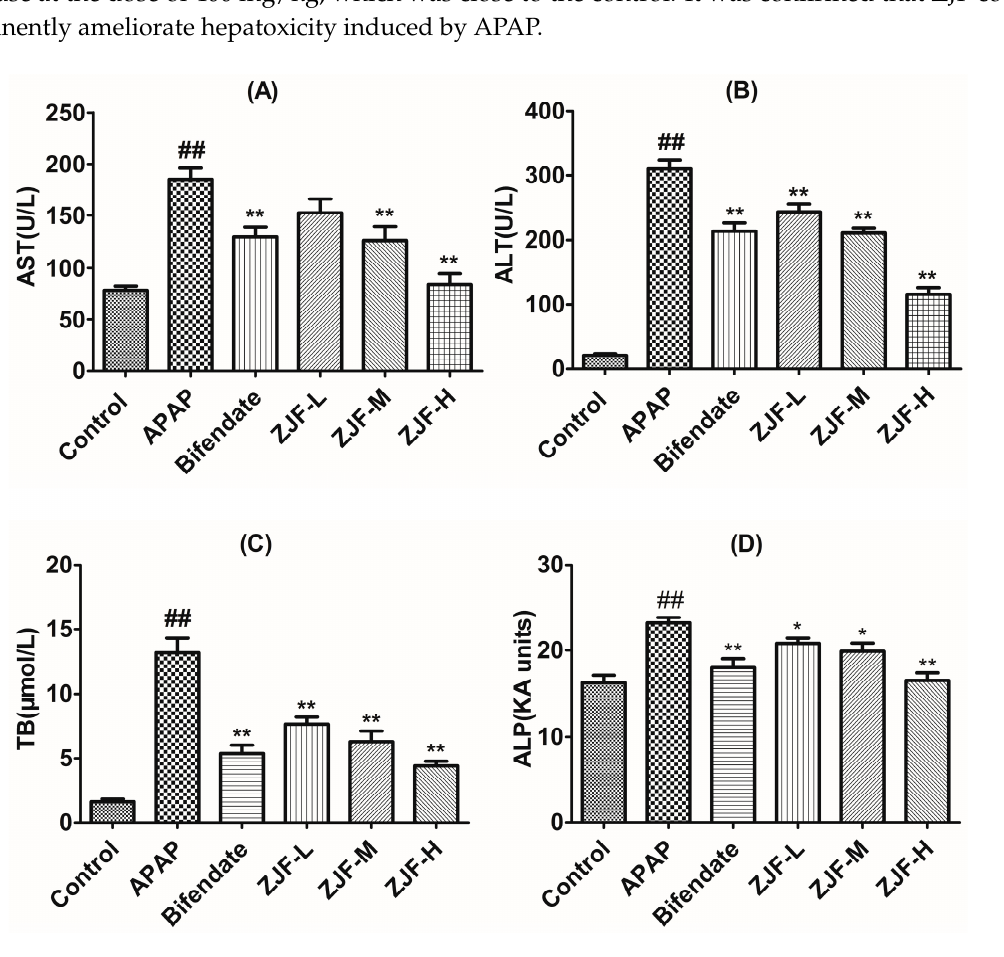
Figure 3. Preventive effects of different doses of ZJF on the activities of serum aspartate aminotransferase (AST), alanine aminotransferase (ALT), total bilirubin (TB), and alkaline phosphatase (ALP) in APAP-induced liver damage mice. ( A ) level of AST; ( B ) level of ALT; ( C ) level of TB; ( D ) level of ALP. Values are presented as Mean ± SEM, n = 6. ## p < 0.01 compared to control group. * p < 0.05 and ** p < 0.01 compared to APAP treated group.